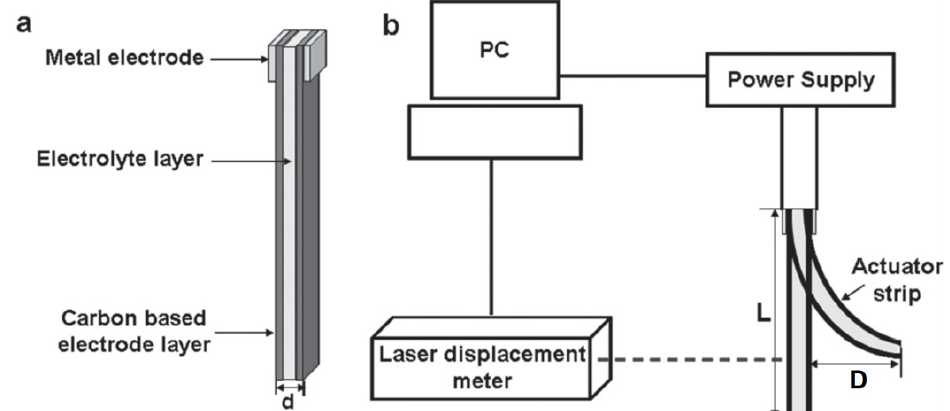
Figure 1. IPMC actuator: ( a ) Schematic of the structure; ( b ) schematic of the measurement. Repro- duced from [3] with permission from John Wiley and Sons. Copyright 2013.